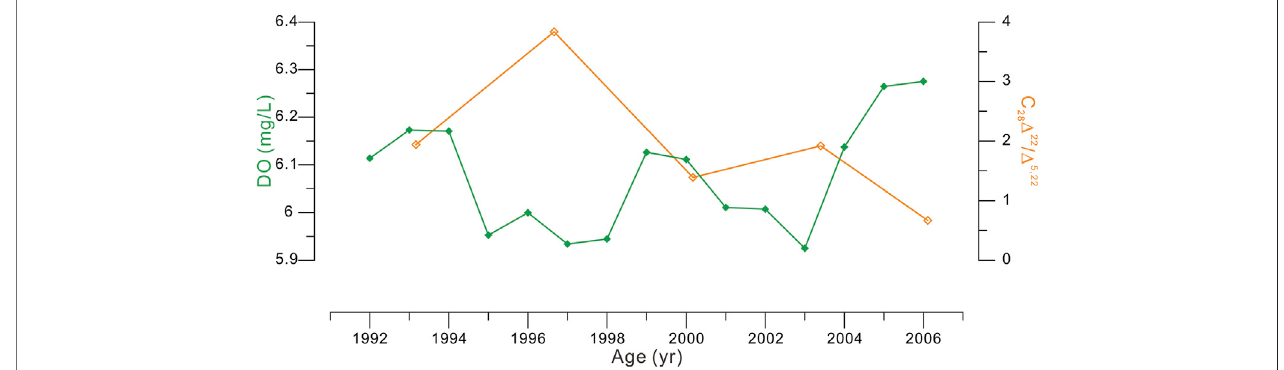
FIGURE 7 | Comparison of the C 28 Δ 22 / Δ 5,22 ratios (orange curve) in core S101 with bottom water DO concentrations (4-year running average; green curve) at proximate station MM13 ( Figure 1 ) during 1991 – 2007. The annual mean DO concentration is estimated from monthly data collected by the Environmental Protection Department, Hong Kong (https://cd.epic.epd.gov.hk/EPICRIVER/marine). Note that monitoring DO data are available since the early 1990s, so given time span (before 2006)andresolution(averaged3.6 yearsper2-cminterval)incoreS101( Table1 ),this fi gureshowsaroughcomparisonbetweenrecordsoftheC 28 Δ 22 / Δ 5,22 ratio and monitoring DO content (4-year running average) during 1991 –